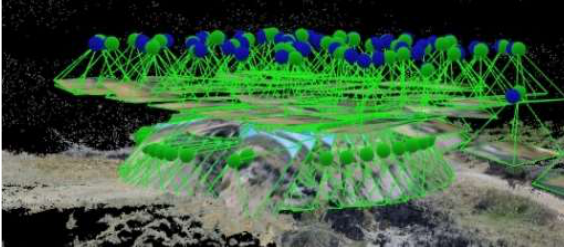
Figure 9. EG at ℎ (cid:3049) = 30 m and RGVC at ℎ (cid:3049) = 50 m. Figure 9. EG at h v = 30 m and RGVC at h v = 50